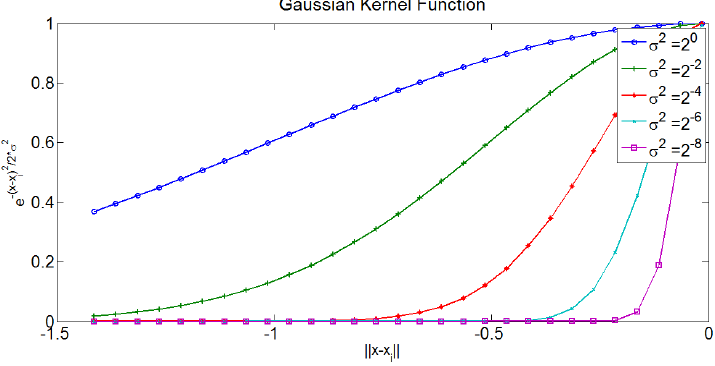
Figure 3. Gaussian kernel